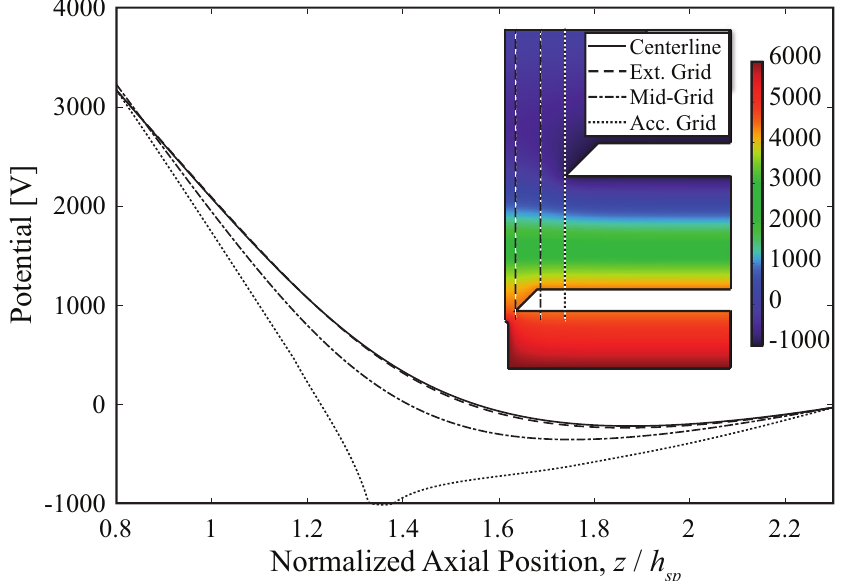
Figure 5. Electric potential along various axial lines showing the potential well that retards backstreaming electrons. Inset: electric potential for nominal geometry with varying axial lines